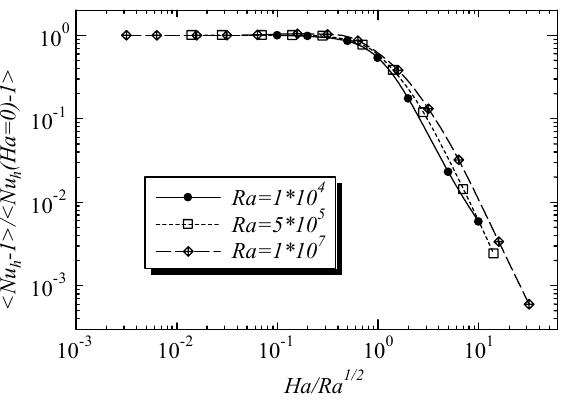
Figure 13. Diagram of < Nu h –1 > to Ha at κ = 0.5. For convenience, the results at Ha = 0 were plotted on the double logarithmic graph, and so Ha = 0 is exactly zero.